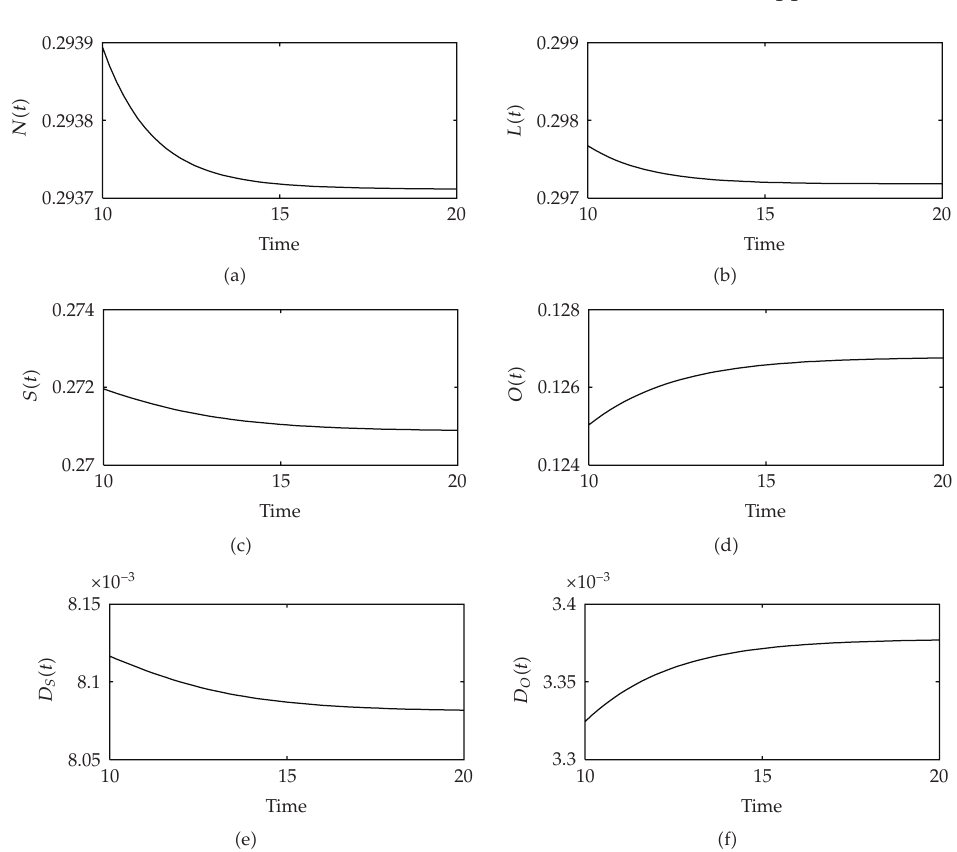
Figure 1: Profiles of subpopulations N (cid:3) t (cid:6) , L (cid:3) t (cid:6) , S (cid:3) t (cid:6) , O (cid:3) t (cid:6) , D S (cid:3) t (cid:6) , and D O (cid:3) t (cid:6) . Solutions are obtained by the proposed NSFD scheme with ψ (cid:3) h (cid:6) (cid:7) h , where h (cid:7) 0 . 2 and initial conditions are N (cid:3) 0 (cid:6) (cid:7) 0 . 462, L (cid:3) 0 (cid:6) (cid:7) 0 . 194, S (cid:3) 0 (cid:6) (cid:7) 0 . 2176, O (cid:3) 0 (cid:6) (cid:7) 0 . 09, D S (cid:3) 0 (cid:6) (cid:7) 0 . 0249, and D O (cid:3) 0 (cid:6) (cid:7) 0 .